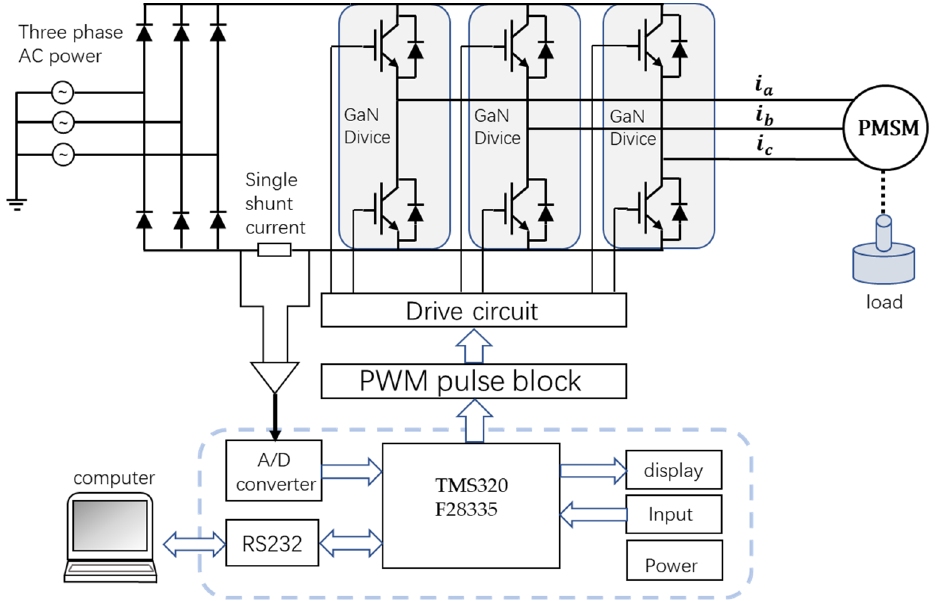
Figure 8. Block diagram of the overall hardware control system.